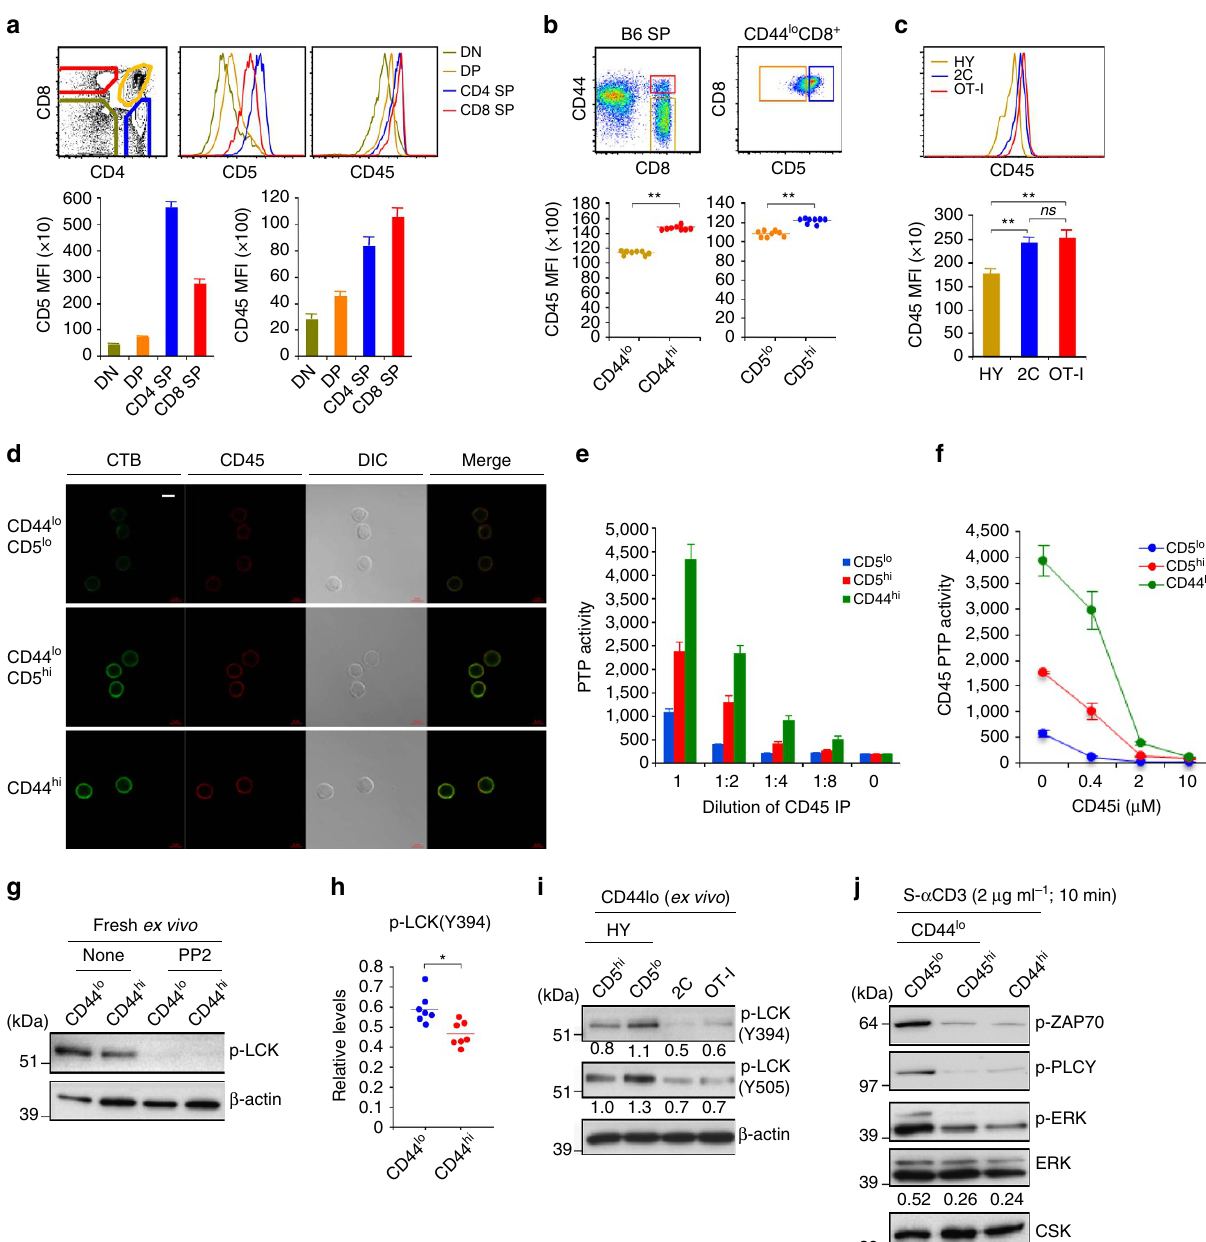
Figure 5 | Expression of CD45 and its PTP activity in CD8 þ Tcell subsets. ( a ) Expression levels for CD5 and CD45 (top) and MFI levels (bottom) on the indicated subsets of B6 thymocytes (means ± s.d.; n ¼ 6). ( b ) Levels of CD45 expression on CD44 lo and CD44 hi (bottom left) or CD44 lo naı¨ve CD5 lo and CD5 hi cells (bottom right) gated for CD8 þ T cells from B6 SP (top; n ¼ 8). ( c ) Levels of CD45 in HY, 2C and OT-I naı¨ve CD8 þ T cells (means ± s.d.; n ¼ 5). ( d ) Confocal staining for CD45 and CTB (to detect lipid rafts) in CD44 lo naı¨ve CD5 lo and CD5 hi cells and CD44 hi MP CD8 þ T cells (original magnification (cid:3) 63; (cid:3) 1.4 zoom; scale bars, 5 m m). ( e , f ) In vitro PTP activity of CD45 immunoprecipitated by anti-CD45 mAb with whole cell lysates from equal numbers of CD44 lo naı¨ve CD5 lo and CD5 hi cells and CD44 hi MP CD8 þ T cells without ( e ) and with indicated concentrations of CD45-specific inhibitor, CD45i ( f ) (means ± s.d.). ( g , h ) Expression ( g , Western blot; h , densitometric levels relative to b -actin) of tyrosine-phosphorylated LCK (Y394) with or without LCK inhibitor PP2 (5 m M) in freshly isolated CD44 lo and CD44 hi B6 CD8 þ Tcells. ( i ) Levels of basal p-Y394-LCK and p-Y505-LCK in freshly isolated HY (CD5 lo ), 2C and OT-I naı¨ve CD8 þ Tcells; note that CD5 hi HYcells are TCR-clonotype negative. ( j ) Levels of phosphorylated ZAP-70, PLC g , and ERK in CD44 lo naı¨ve CD45 lo and CD45 hi cells and CD44 hi MP CD8 þ Tcells after incubation with S- a CD3 mAb. Data are representative of two ( a , c , d ), at least three ( b , e , f , i , j ) and seven independent experiments ( g , h ). Unpaired Student’s t -test was used for the statistical analysis. * P o 0.005; ** P o 0.0005; ns, not